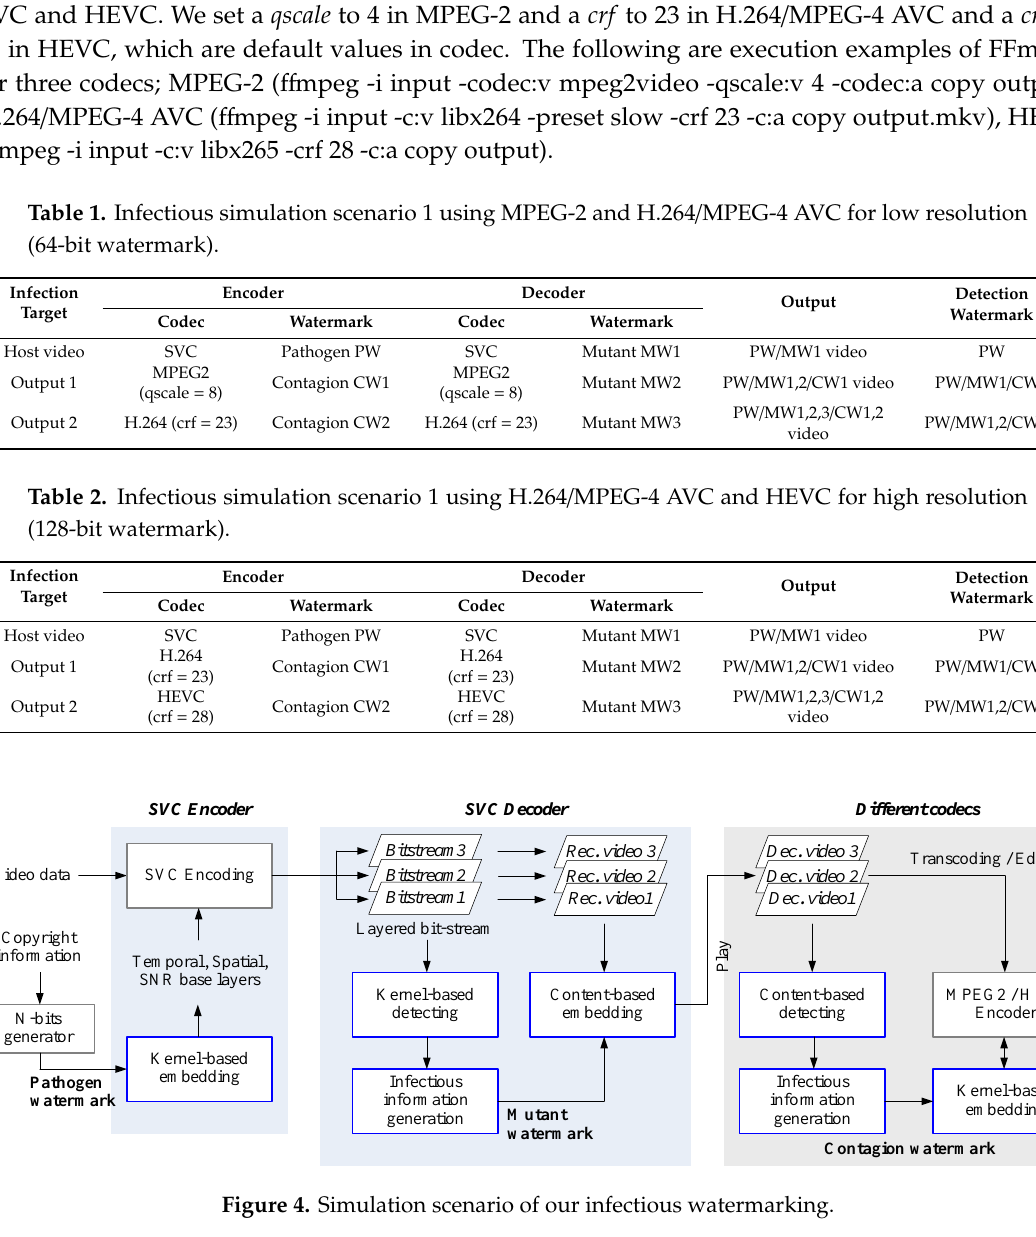
Table 1. Infectious simulation scenario 1 using MPEG-2 and H.264/MPEG-4 AVC for low resolution (64-bit watermark).